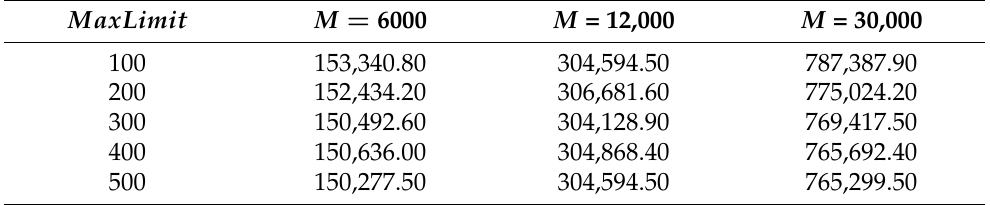
Table 5. The performance of NSGA-III vs. different MaxLimit for different M for t